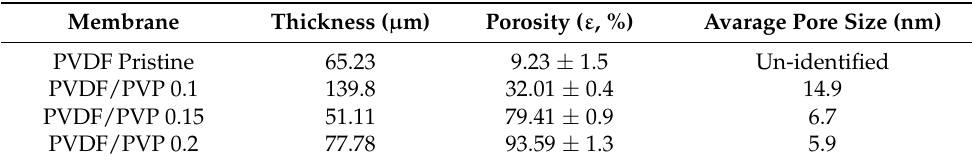
Table 3. Thickness, porosity, and average pore size of the membranes.